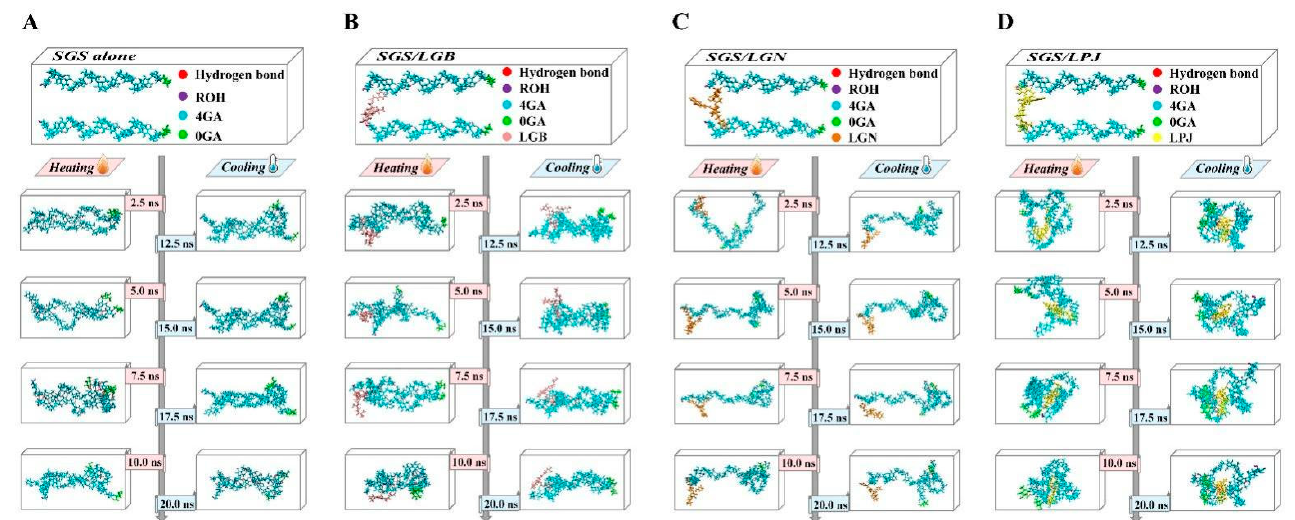
Figure 5. Trajectory of molecular dynamics simulation. ( A ) Trajectory between two SGS chains, ( B ) trajectory between LGB and two SGS chains, ( C ) trajectory between LGN and two SGS chains, ( D ) trajectory between LPJ and two SGS chains. (The glucose residue at the beginning of starch stand is 0GA, the glucose residue in the middle of starch strand is 4GA and the hydroxyl group at the end of starch strand is ROH.) LRE: Ligustrum robustum (Rxob.) Blume extract.